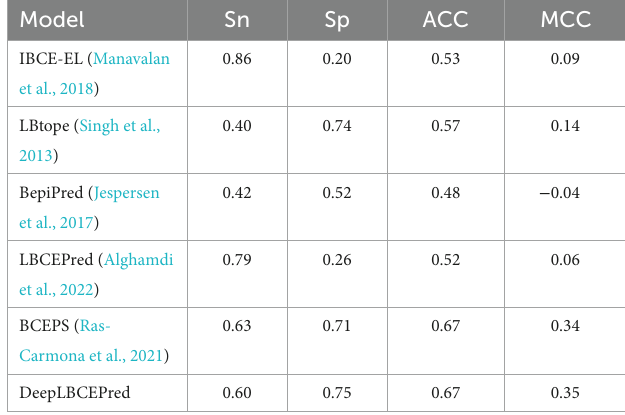
TABLE 6 Comparison with existing models on the IDED 1246 independent